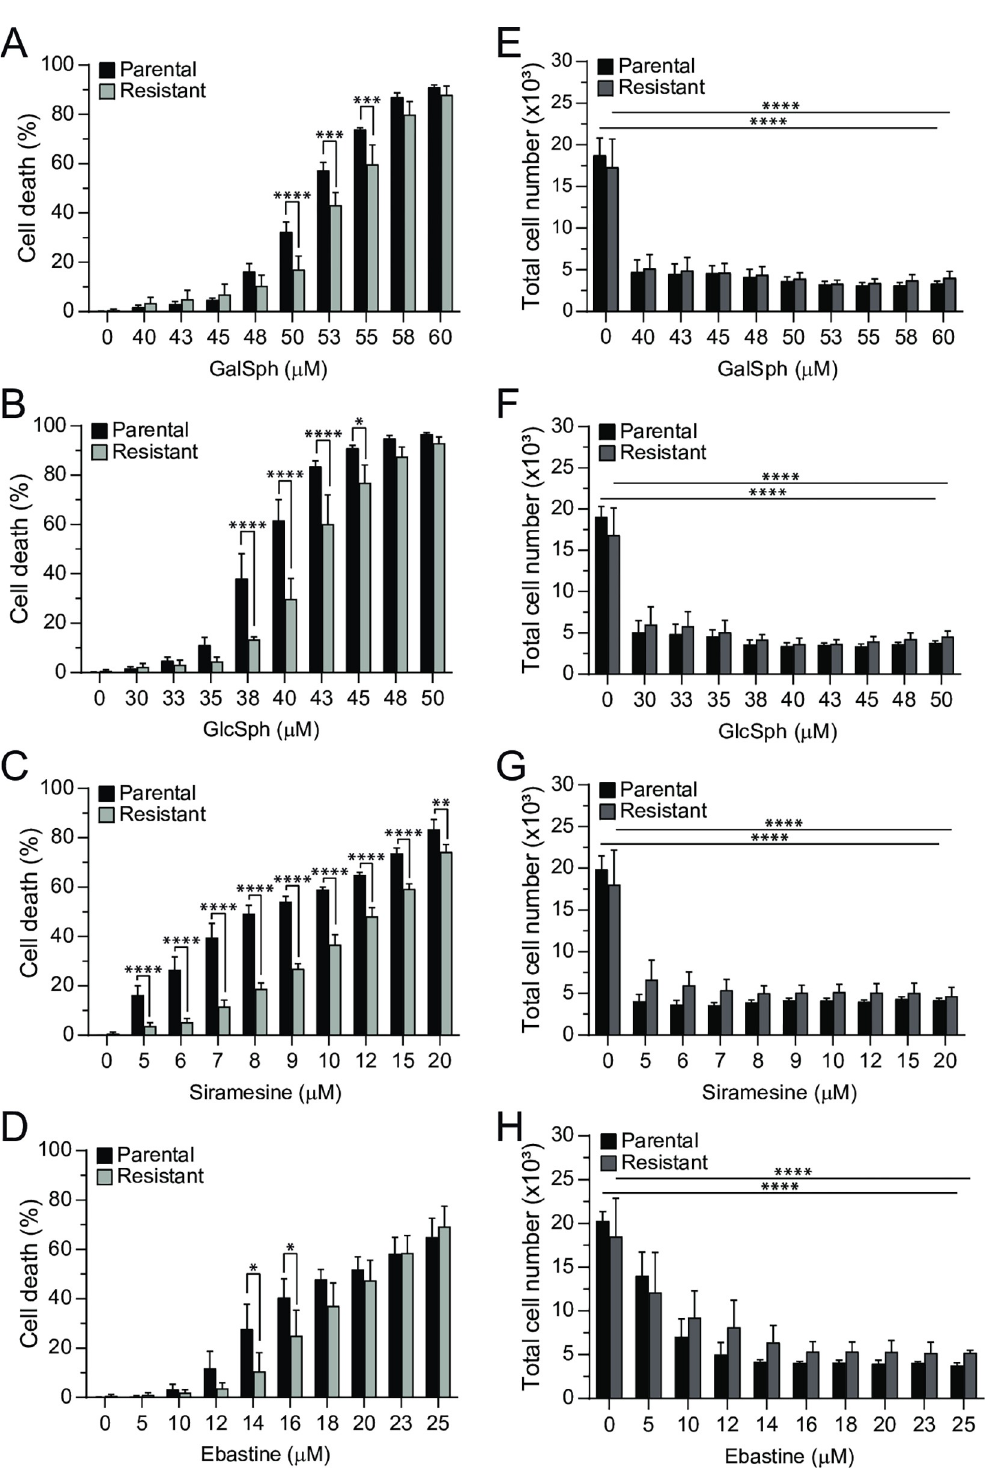
Fig 2. CAD-resistant MCF7 cells are resistant against GalSph- and GlcSph-induced cell death but not to growth inhibition. (A-D) Death of parental and CAD-resistant MCF7 cells treated for 48 hours with indicated concentrations of GalSph (A), GlcSph (B), siramesine (C, positive control), or ebastine (D, positive control) was determined as in in Fig 1A. (E-H) Total cell numbers of parental and CAD-resistant MCF7 cells treated with indicated concentrations of GalSph (E), GlcSph (F), siramesine (positive control) (G), or ebastine (positive control) (H) for 48 hours were determined by Hoechst- 33342 staining employing Celigo Imaging Cytometer. Error bars, SD of three independent experiments. � , P < 0.05; �� , P < 0.01; ��� , P < 0.001; ���� , P < 0.0001 as analyzed by two-way ANOVA followed by Sidak’s multiple comparisons